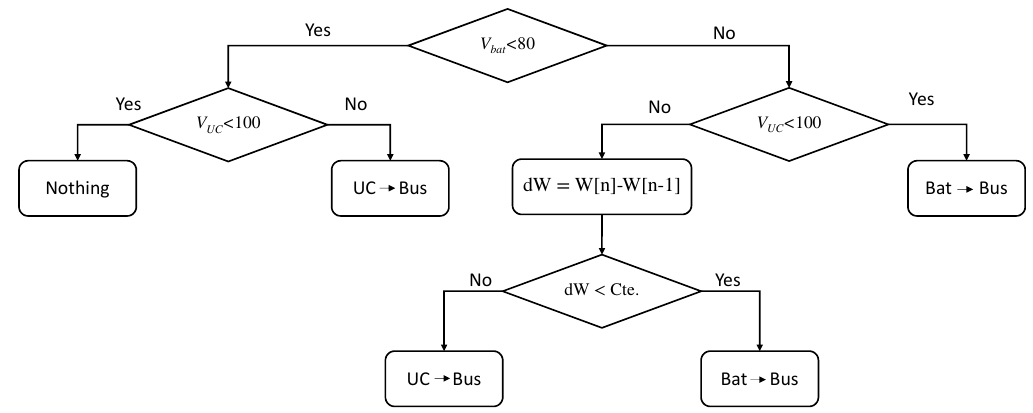
Figure 12. Flowchart followed by the EMS when the vehicle is in motion and there is energy in both power